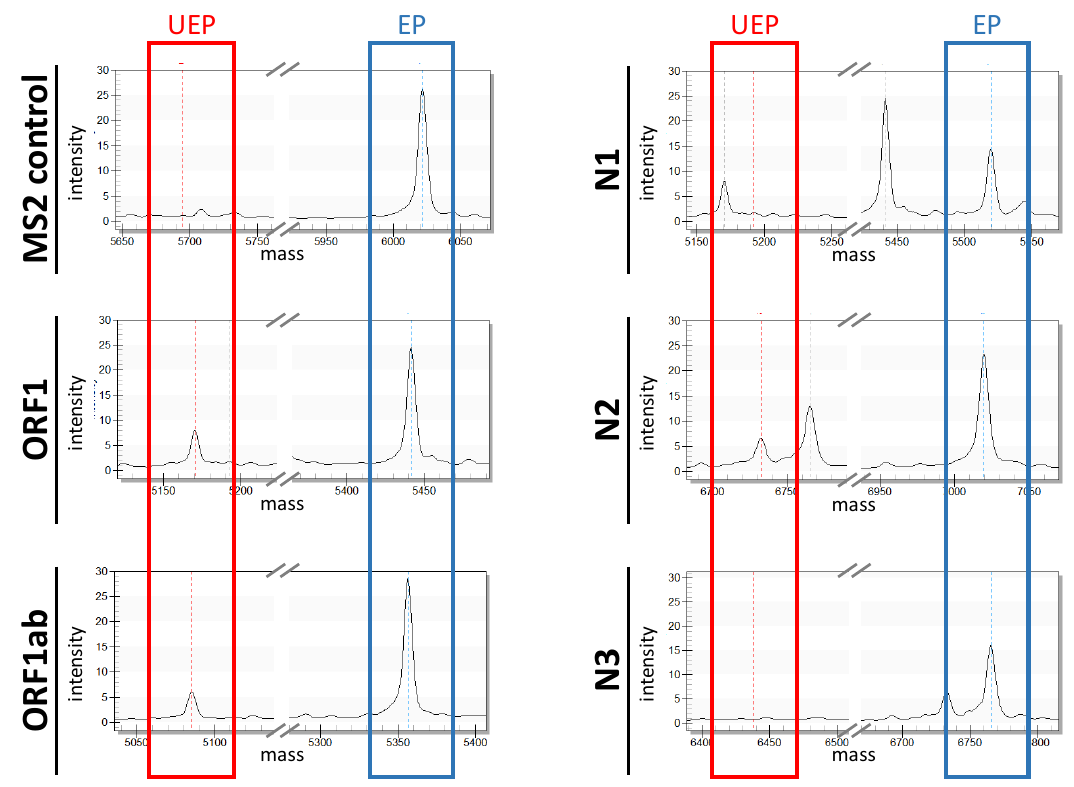
Figure 3. Representative mass spectra of a positive sample analyzed by the CE-IVD-certified MassARRAY SARS-CoV-2 Panel. The different mass spectra display intensity and mass (in daltons) of the SARS-CoV-2 -specific cDNA fragments ORF1, ORF1ab, N1, N2 and N3. Additionally, the mass spectrum of the MS2 phage control is depicted. The red box highlights the unextended extension primer peak, whereas the blue box highlights the peak corresponding to the extension product. UEP: unextended extension primer; EP: extension product.